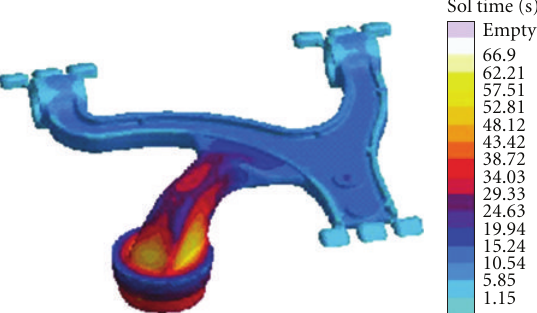
Figure 4: Solidification time distribution of arm